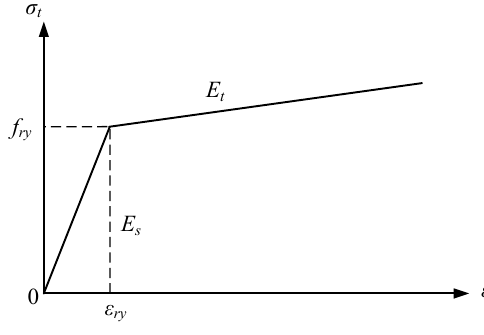
Figure 4. Bilinear stress–strain relation model.